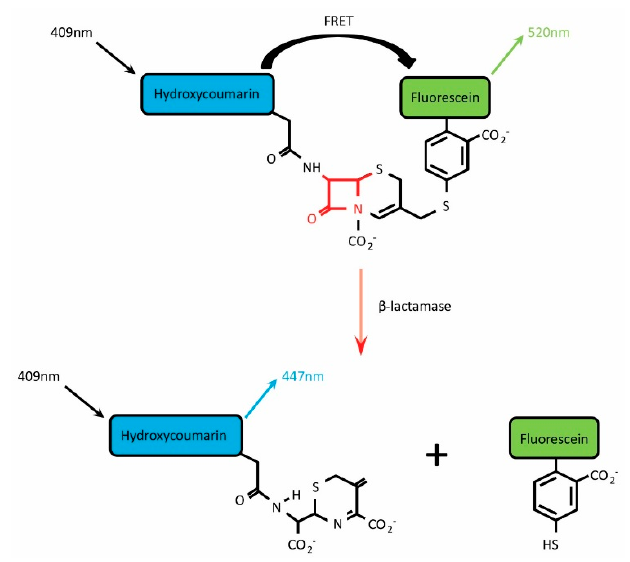
Figure 1. CCF2-AM is composed of a Hydroxycoumarin donor conjugated to a Fluorescein acceptor via a β -lactam ring. In the absence of β -lactamase, excitation at 409 nm promotes Förster resonance energy transfer (FRET) between the fluorescent donor and acceptor molecules, resulting in emission at 520 nm. Cleavage of the β -lactam ring by β -lactamase separates the two molecules, disrupting FRET and producing a fluorescence shift from 520 nm to 447 nm.